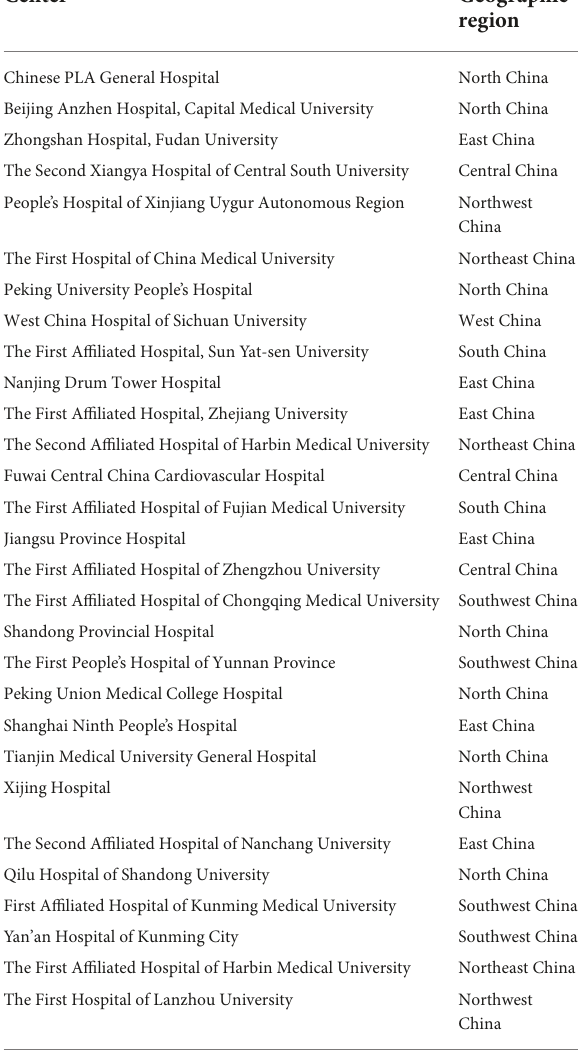
TABLE 2 Trial centers.